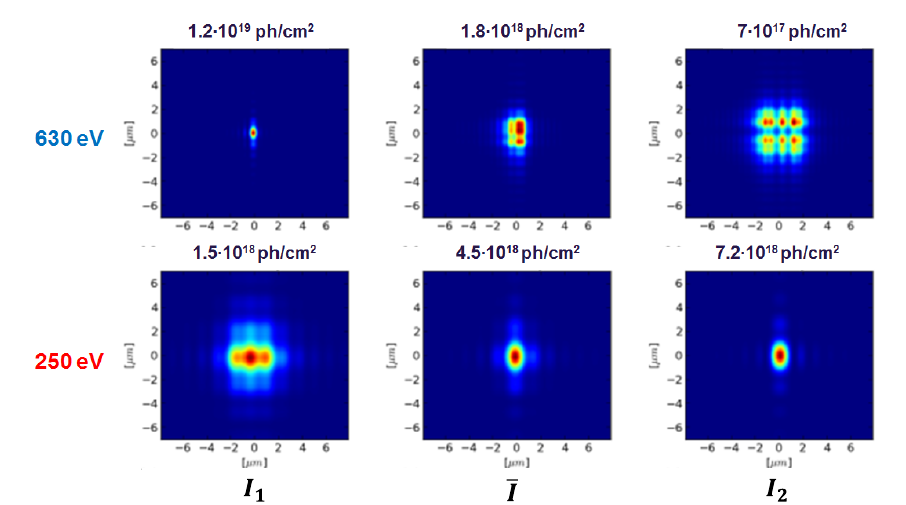
Figure 10. False color representation of radiation intensity distribution of both radiation pulses with different photon energies at various image planes from Figure 9. Peak photon density is provided above the plots. The method of an intermediate source re-imaging would allow one to obtain comparable radiation distribution size as well as the photon